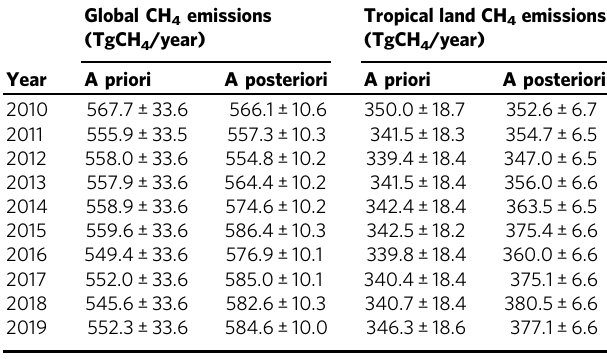
a posteriori CH 4 fl uxes (TgCH 4 /year) from 2010 to 2019,